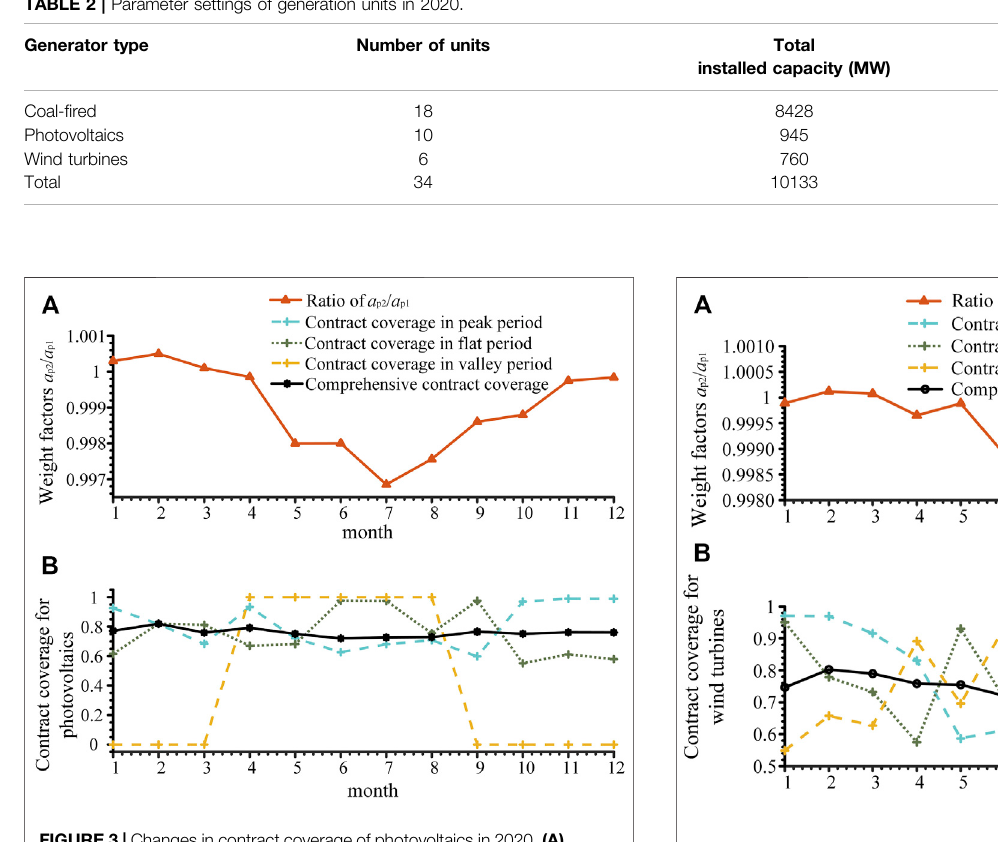
FIGURE 3 | Changes in contract coverage of photovoltaics in 2020. (A) Change of weight factors. (B) Change of contract coverage. FIGURE 4 | Changes in contract coverage of wind turbines in 2020. (A) Change of weight factors. (B) Change in contract coverage.